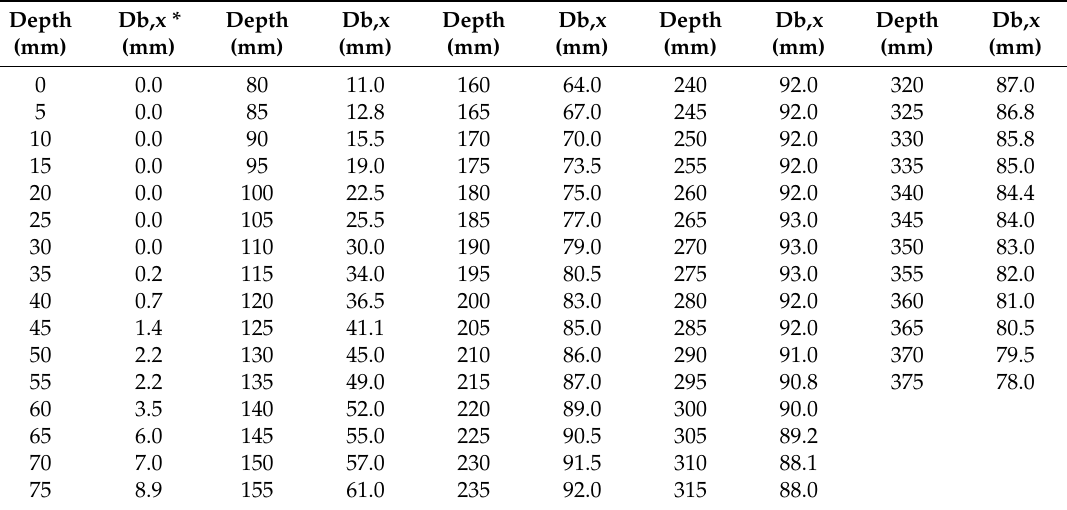
Table 1. Baseline data read by checkered paper.